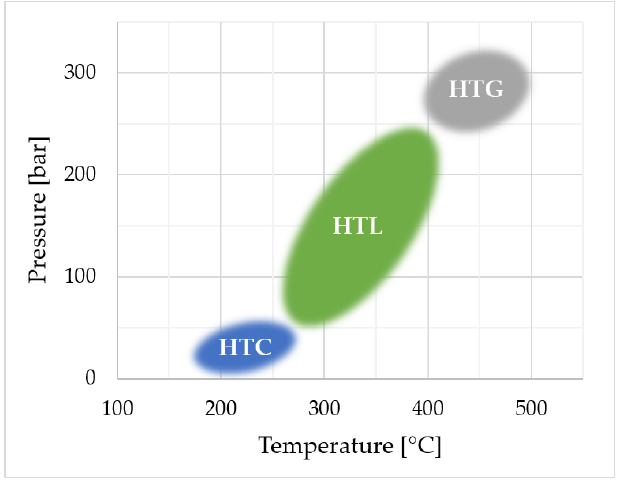
Figure 1. Operating temperatures and pressures of hydrothermal technologies.